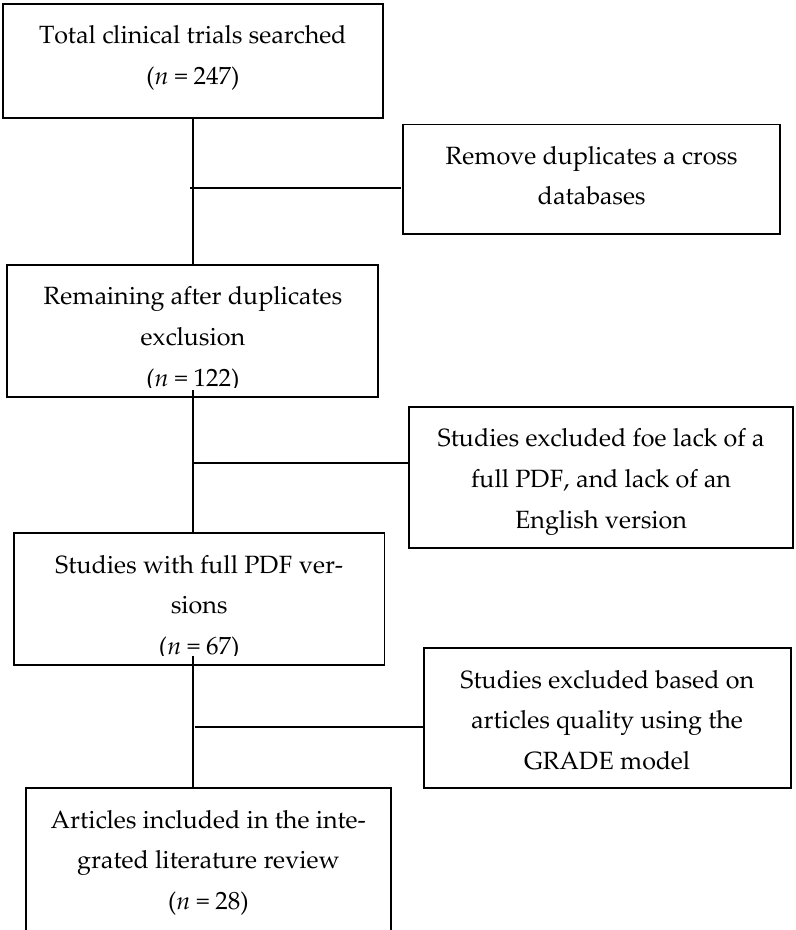
Figure 1. Flowchart of the study selection process.